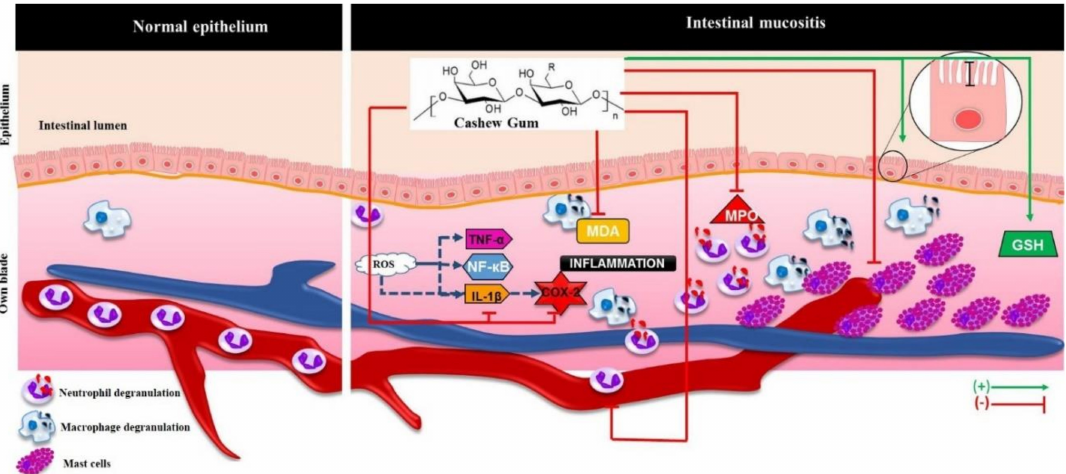
Figure 7. Hypothetical model of action of CG in intestinal mucositis induced by 5-FU. CG prevented the 5-FU-induced injury intestinal through inhibition of MDA formation, neutrophil recruitment (decreasing MPO levels), mast cells activation and IL-1 β and COX-2 immunostaining marker and inhibited leucopenia. CG also stimulate villus enlargement and increase levels of GSH, an antioxidant. ROS: Reactive Oxygen Species; TNF- α : Tumor Necrosis Factor-alpha; NF- κ B: transcription factor nuclear kappa b; IL-1 β : Interleukin 1 beta; COX-2: Cyclooxygenase 2; MDA: Malondialdehyde; MPO: Myeloperoxidase; GSH: Reduced glutathione. Arrows green (stimulate / increase), red arrows